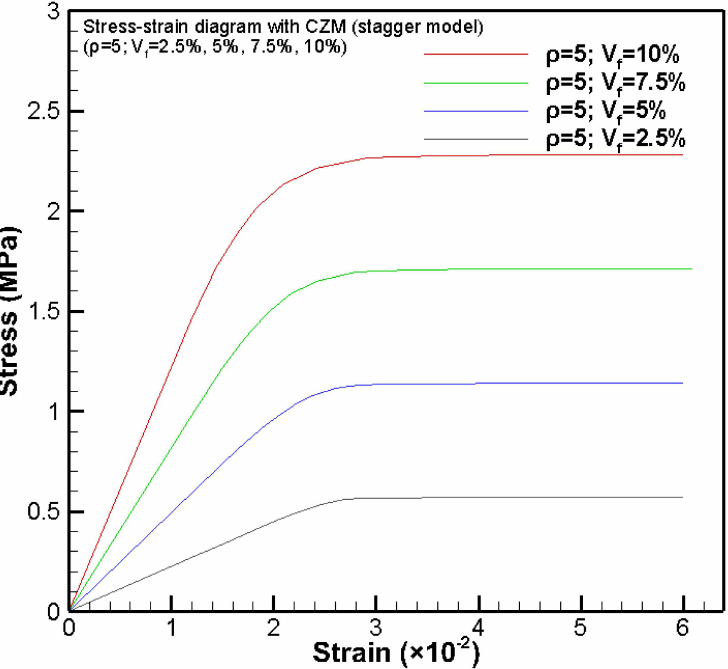
Figure 14. Effective stress-strain diagrams of the PNC (stagger nanoparticle configuration) with CZM at the nanoparticle volume fractions V f = 2.5%, 5%, 7.5%, and 10% at the clay particle aspect ratio ρ = 5.